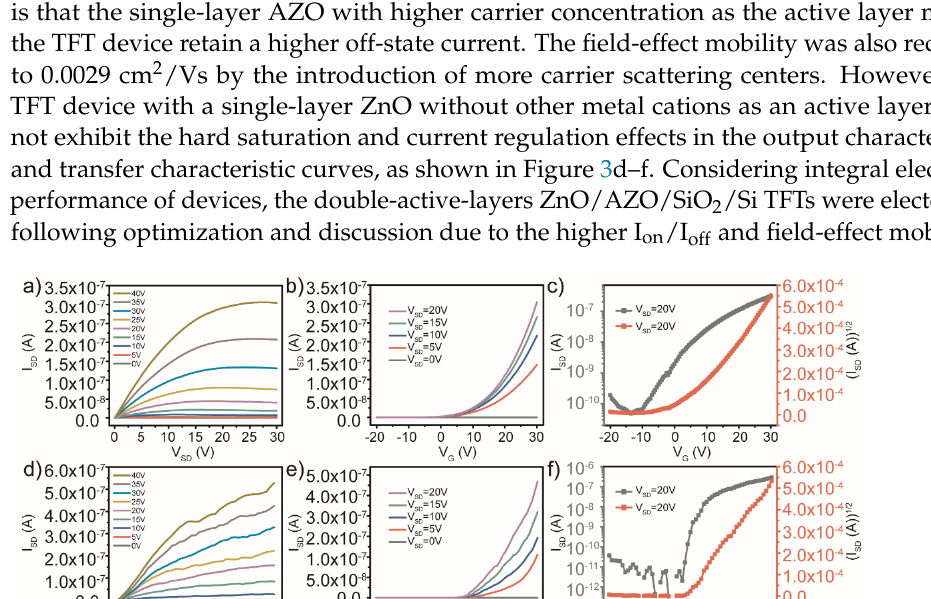
Figure 2. Schematic diagrams of cross ‐ section structure of oxide TFTs with ZnO/AZO/SiO 2 /Si ( a ) and AZO/ZnO/SiO 2 /Si ( b ) double-active-layers. Output characteristics and transfer characteristics of TFTs with ZnO/AZO/SiO 2 /Si layers ( c – e ) and with AZO/ZnO/SiO 2 /Si layers ( f – h ).